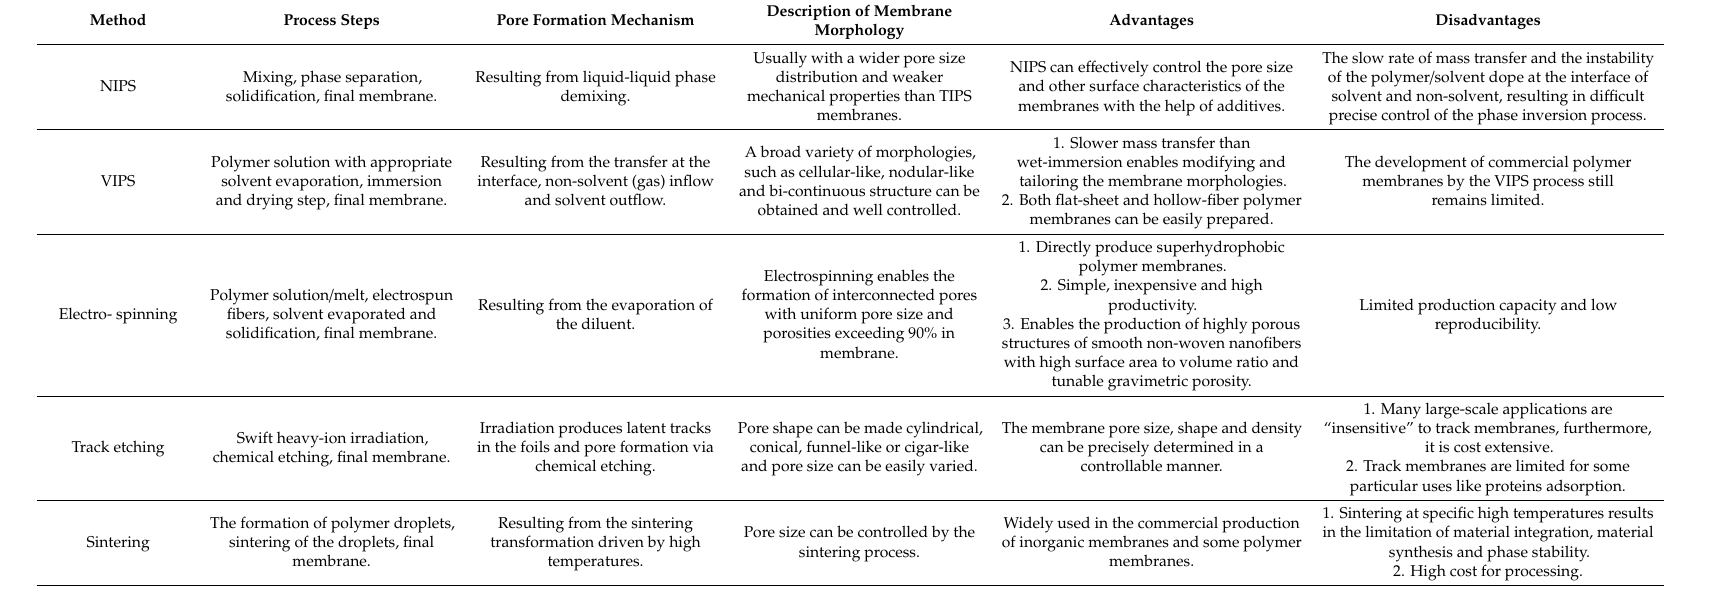
Table 11. Comparison of the various production methods